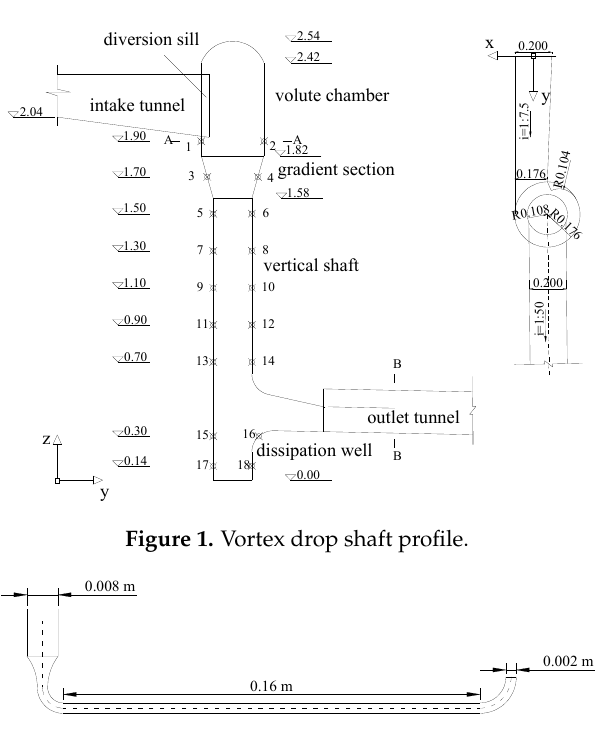
Figure 2. The structure of L-shaped tube.